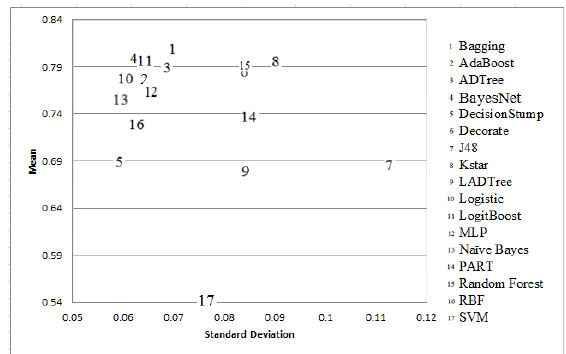
Figure 12. AUC mean of all scenarios and deviation from mean for classification of all datasets.